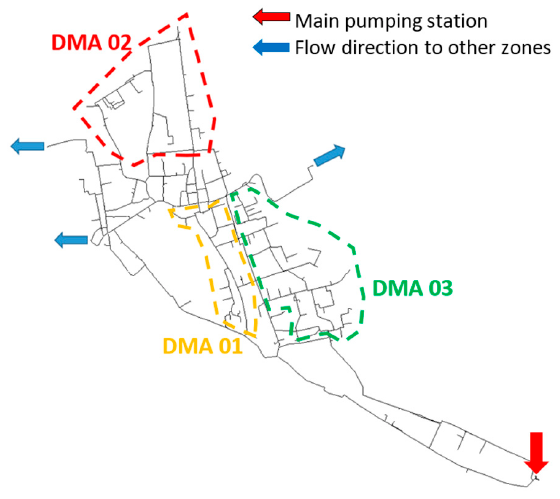
Figure 4. The division of the selected zone of the network into DMAs.